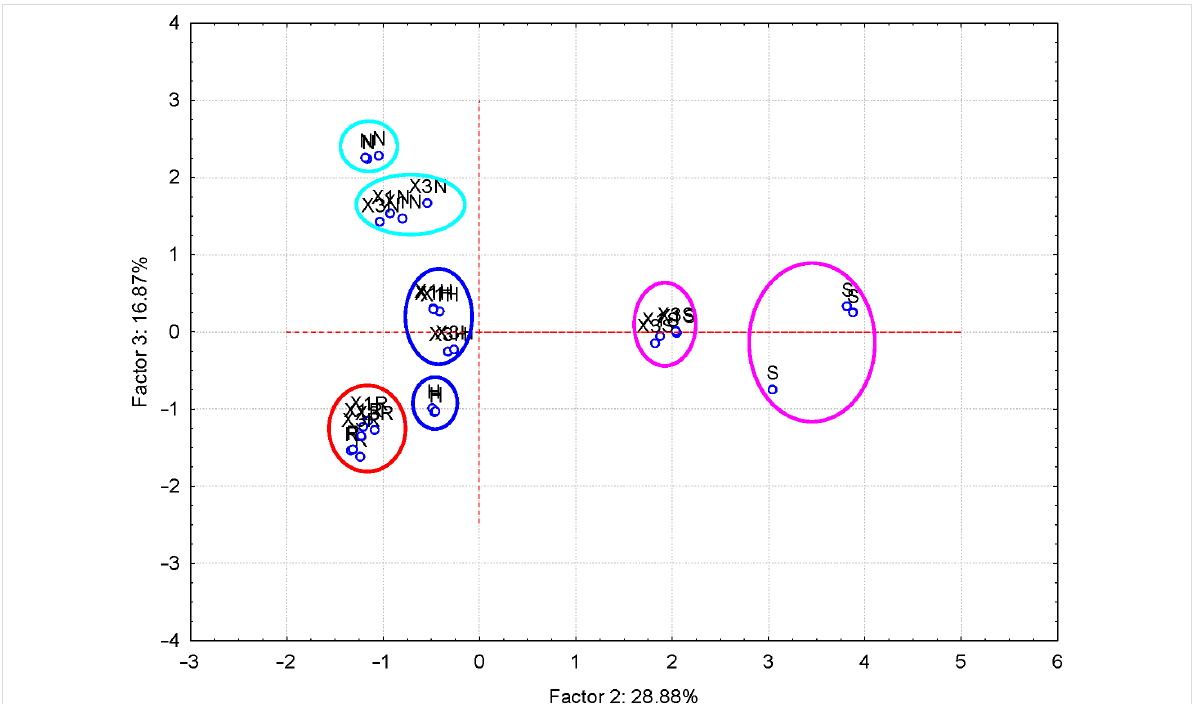
Figure 9: PC 3 versus PC 2 scores plot from the FTIR–PCA analysis of the β -CD/hazelnut oil/flavonoid ternary complexes (codes: “X1H/N/R/S” and “X3H/N/R/S” for the 1:1:1 and 3:1:1 ternary complexes with hesperidin/naringin/rutin/silymarin, respectively) and flavonoids (codes: “H” – hesperidin, “N” – naringin, “R” – rutin and “S” – silymarin); only wavenumbers of the FTIR bands were used as input variables.